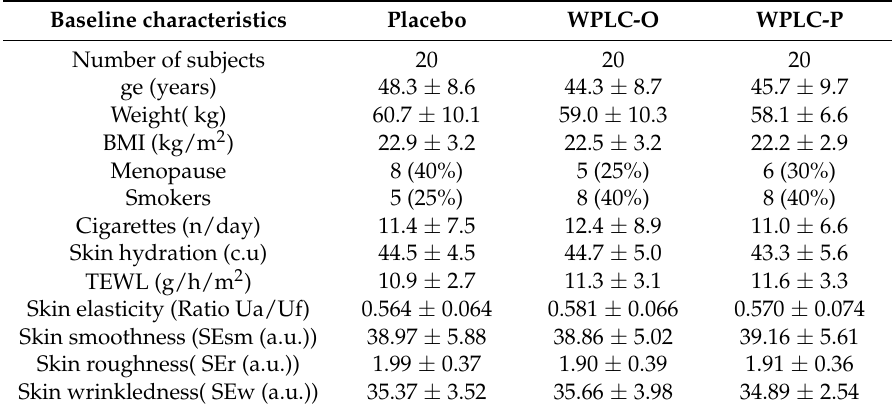
Table 5. Subjects’ baseline demographic and clinical